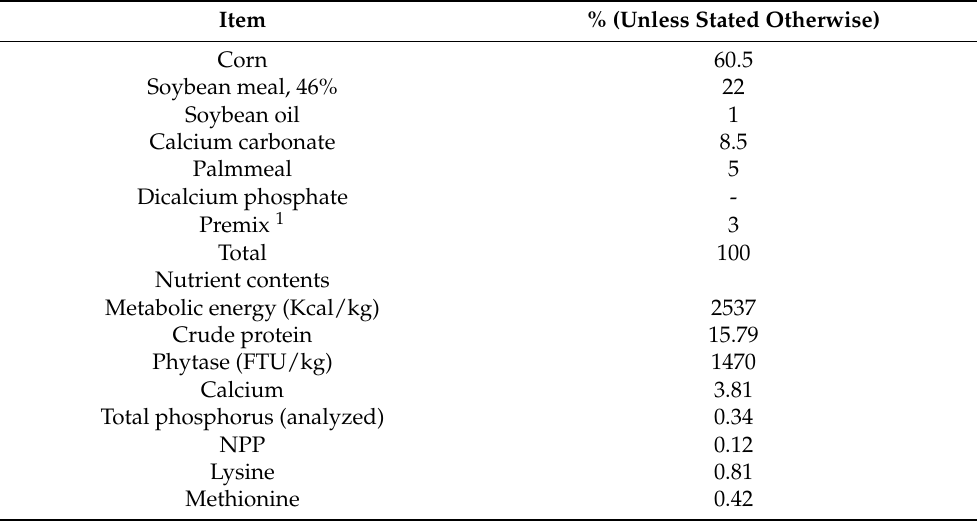
Table 1. Composition and nutrient contents of the basal